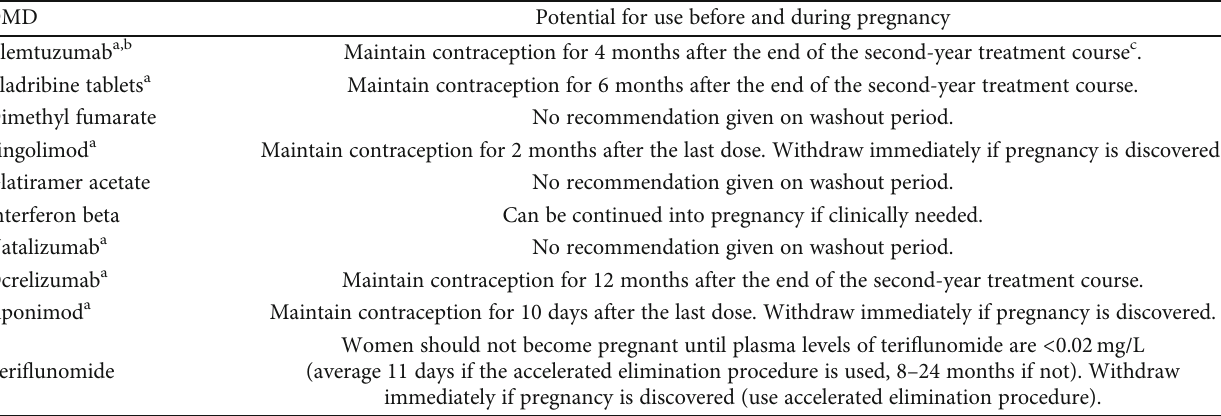
Table 1: Practical considerations relating to the use of disease-modifying drugs before and during pregnancy, according to European labelling. DMD Potential for use before and during pregnancy Alemtuzumab a,b Maintain contraception for 4 months after the end of the second-year treatment course c . Cladribine tablets a Dimethyl fumarate Glatiramer acetate